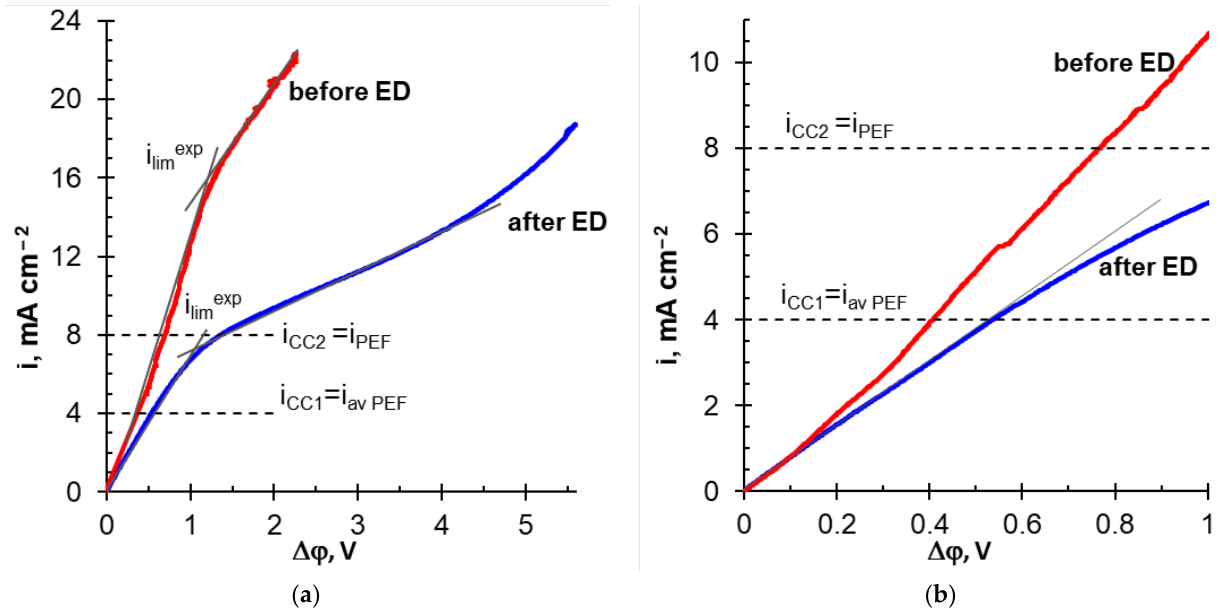
Figure 7. Current – voltage curves of the MA-41P membrane before and after ED desalination of the Figure 7. Current–voltage curves of the MA-41P membrane before and after ED desalination of the multicomponent solution ( a ) and initial sections of these curves ( b ) . multicomponent solution ( a ) and initial sections of these curves ( b